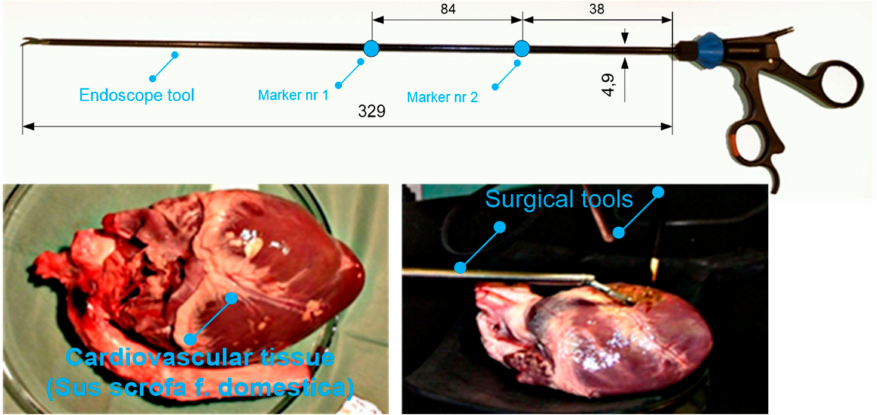
Figure 6. An endoscopic tool with four degrees of freedom when it is moved through the trocar and cardiovascular tissue on which the experiments were carried out with the use of an optical